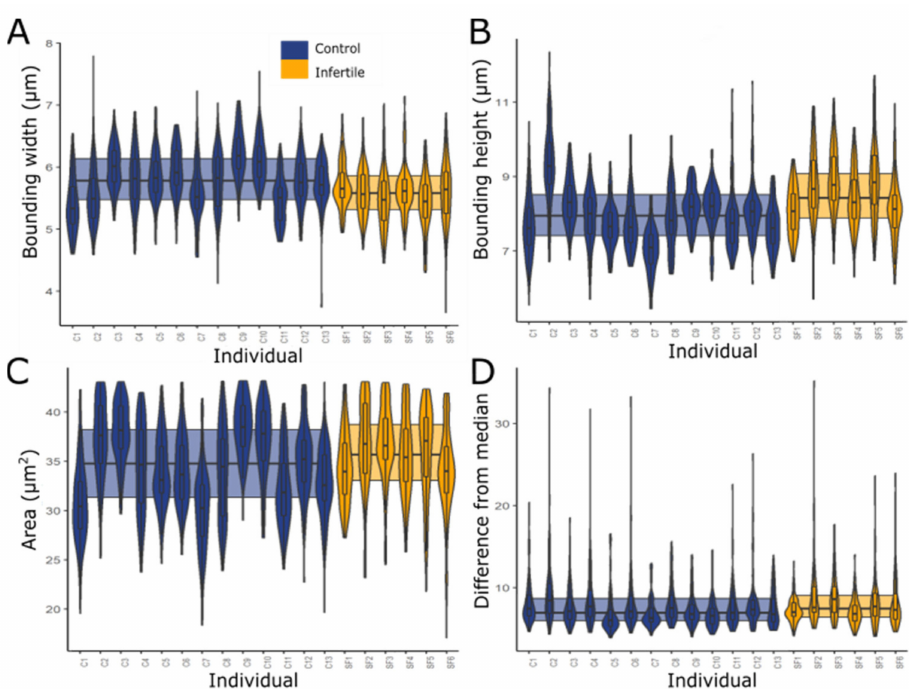
Figure 1. Comparison of nuclear morphologies between control and infertile individuals. ( A ) bounding widths; ( B ) bound- ing heights; ( C ) area shows infertile sperm nuclei are longer and thinner, and overall, larger. ( D ) Difference from median shows slightly increased variability of the nuclear shapes within each sample. The median and upper and lower quartiles are also shown for each